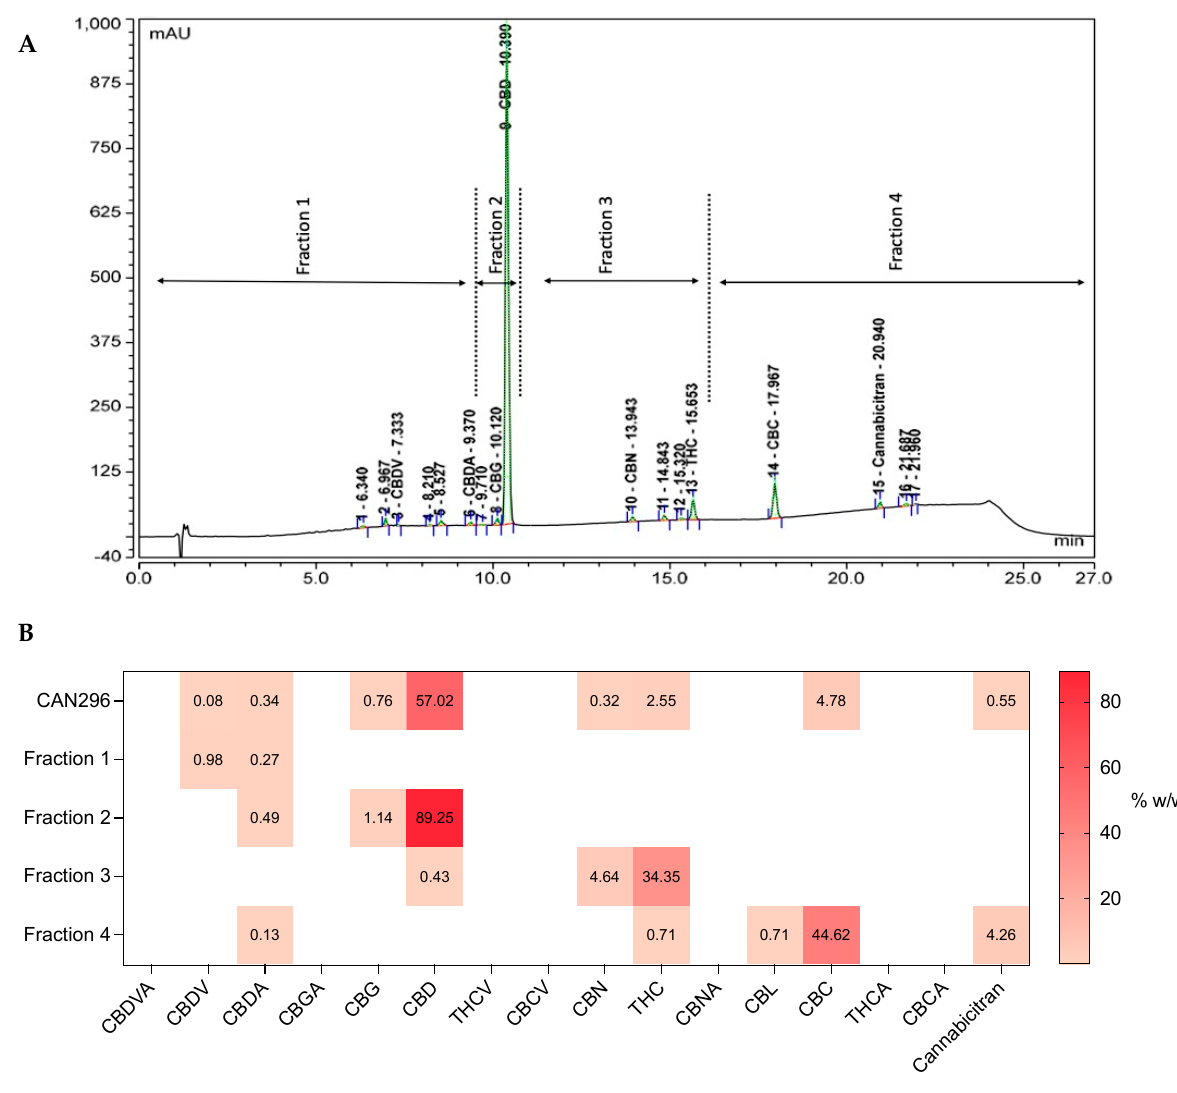
Figure 6. Chromatographic separation & heatmap clustering of the cannabinoid content of CAN296 and its fractions 1–4. ( A ) UHPLC chromatogram of cannabis extract CAN296; vertical lines indicate the retention time cutoff: fraction 1, 0–9.36 min; fraction 2, 9.36–10.393 min; fraction 3, 10.42–15.653 min; fraction 4, 15.657–21.963 min. ( B ) Heatmap of CAN296 and fraction 1–4 cannabinoids content. The values present the content percent w/w of each of the tested cannabinoids in the whole extract and each fraction according to ESI-LC/MS analysis. Higher scores (darker red) indicate a higher percentage of the cannabinoid.